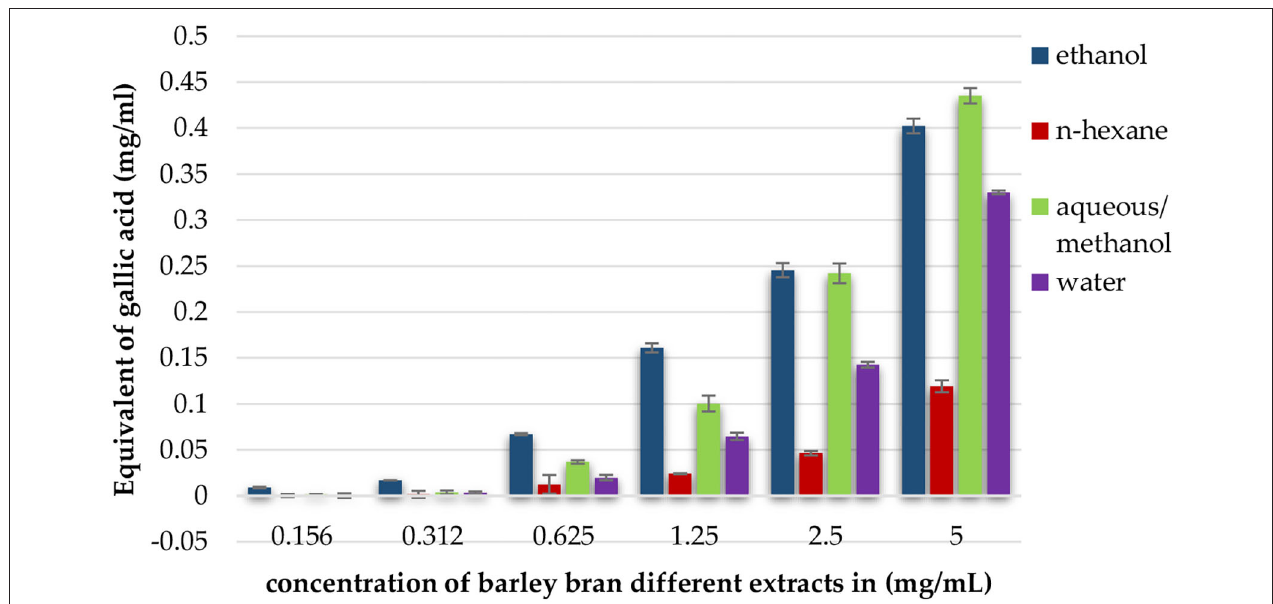
FIGURE 2 | Total phenolic content expressed as equivalent of gallic acid in mg per ml of ethanol, n -hexane, aqueous/methanol, and water extracts of barley bran in different concentrations.